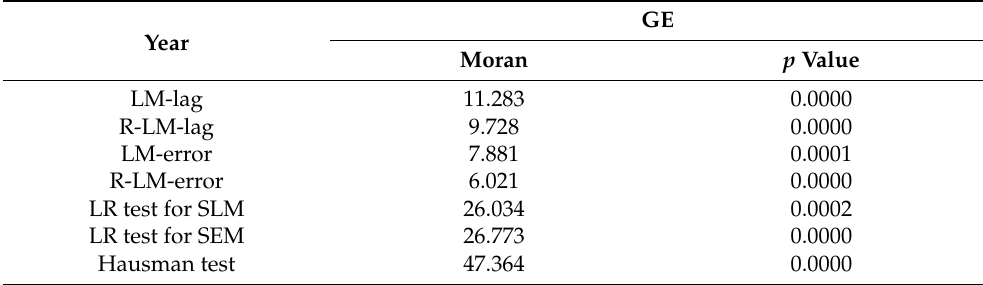
Table 6. Spatial econometric model test results.